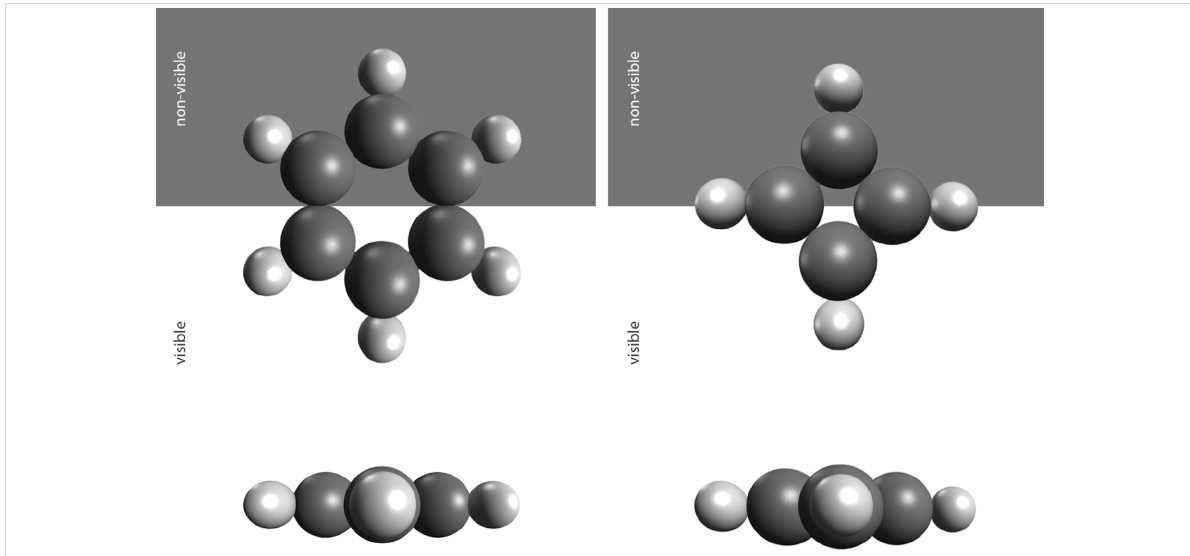
Figure 3: Left: benzene from two different angles, PI code of benzene: PI = 1/2D/C3H3/cX1-1-2-3-X2-X3-X1/h1-3H; PI code with specific indication of benzene: PI = 1/2D/C3H3/ cX1-1-2-3-X2-X3-X1/h1-3H//xX1-X3C/hxX1-X3H. Right: cyclobutadiene from two different angles, PI code of cyclobuta- diene: PI = 1/2D/C3H3/cX1-1-2-3-X1/h1-3H; Pi code with specific indication of cyclobutadiene: PI = 1/2D/C3H3/cX1-1-2-3-X1/h1-3H//xX1C/hxX1H.’ IMPORTANT: no subscript in the